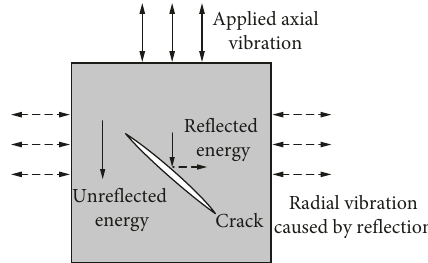
Figure 10: Ultrasonic energy propagation